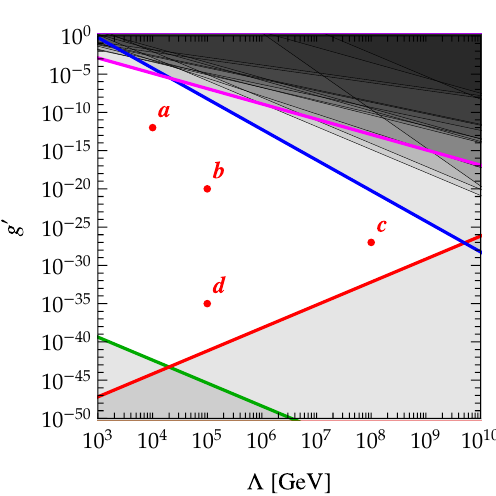
Figure 13 . Details of the origin of the constraints delimitating the green region presented in sec- tion 3.1 and (cid:12)gure 2 corresponding to the case where relaxation happens through Higgs-dependent barriers, during a stage of in(cid:13)ation, where the relaxion is a subdominant component of the energy density of the universe and where the relaxion stops because of Hubble friction (so-called GKR case) .